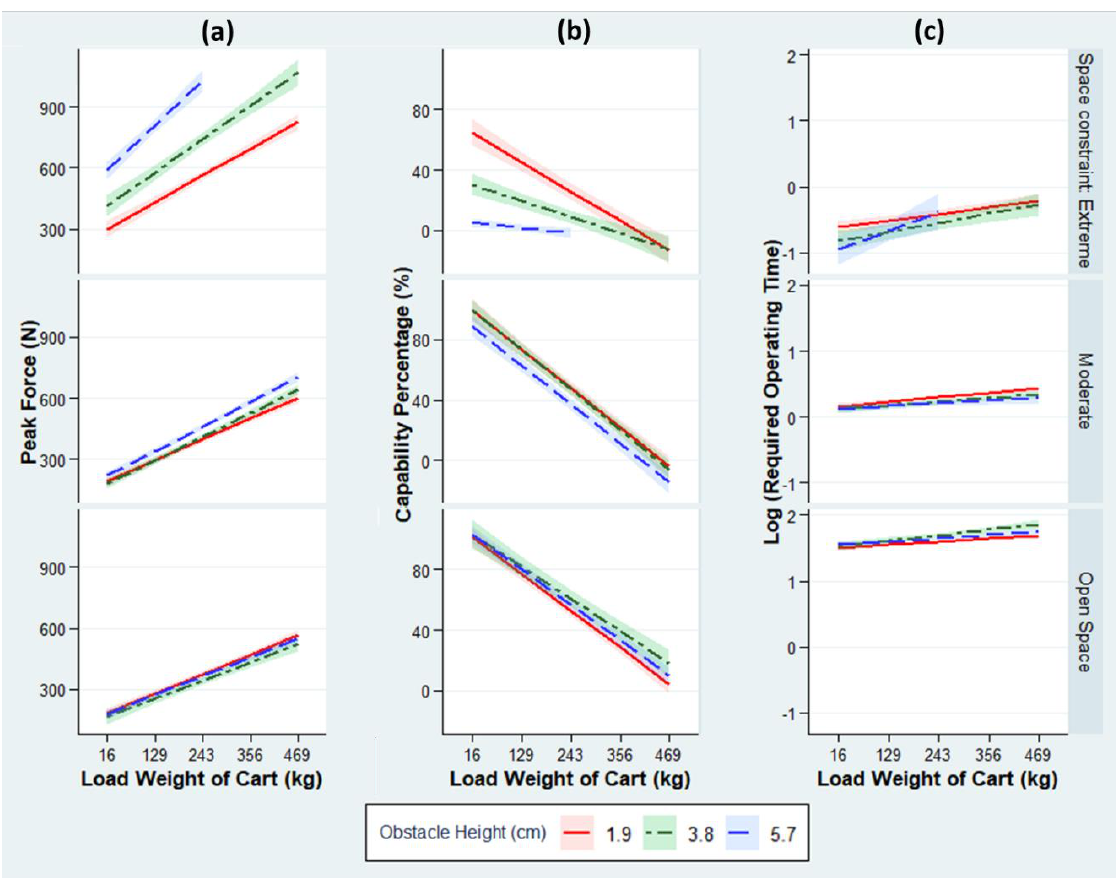
Figure 8. Estimated values: ( a ) ROF, ( b ) CP, and ( c ) ROT for three obstacle heights by fitting the actual measurements in Experiment 2a from the final linear regression models, stratified by the space constraint. The estimated values are adjusted for tire type. The ribbons indicate 95% confidence intervals.